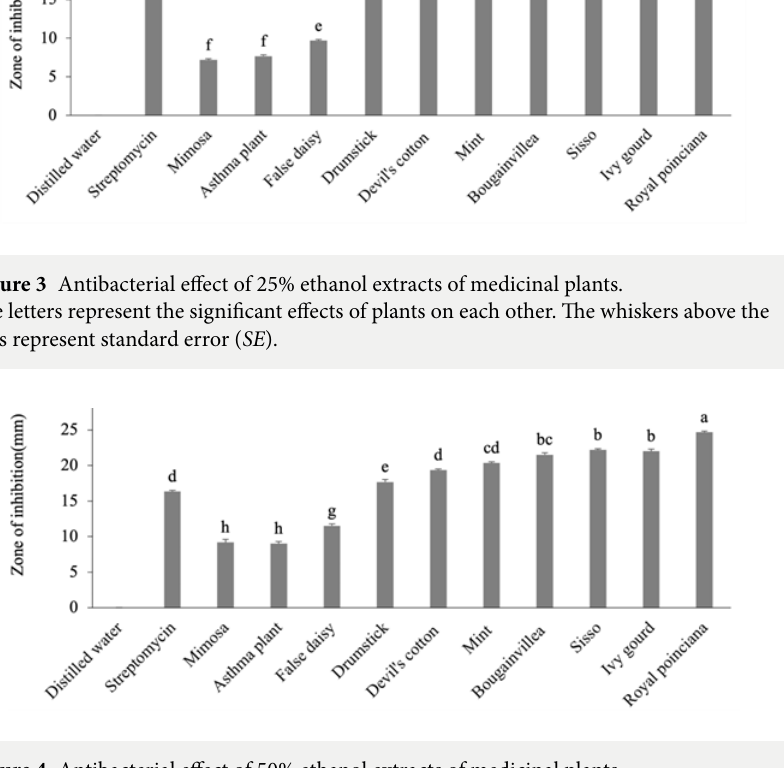
Figure 4 Antibacterial effect of 50% ethanol extracts of medicinal plants. e letters represent the significant effects of plants on each other. e whiskers above the bars represent standard error ( SE